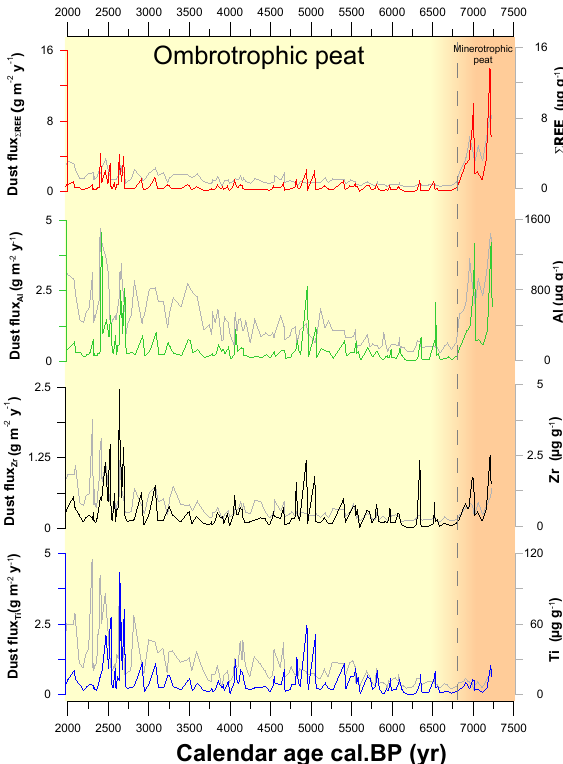
Fig. 5. Dust flux given in units of gm − 2 yr − 1 calculated for Ti, Zr, Al and P REE. Grey lines correspond to Ti, Zr, Al and P REE concentrations. The yellow area corresponds to the ombrotrophic peatland, and the brown area to minerotrophic